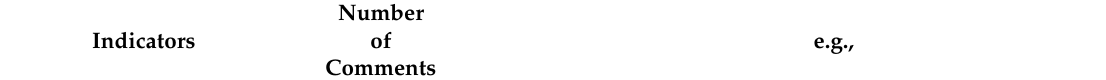
Table 9. Categorisation and quantification of students’